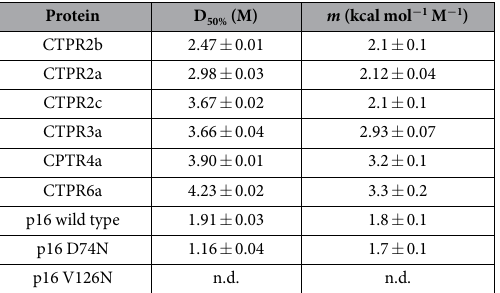
protein engineering/folding studies (Fig. S1(a)). Figure S1(b) shows the normalised data. The fluorimeter and plate-reader data overlay, and the CD data also give similar results within error (see D 50% and m -values listed in Table S1). The final set of samples that we tested using the plate-reader method were a selection of previously published proteins kindly given to us by colleagues in Cambridge. They are representative of proteins having a range of different stabilities, folding behaviour (two/three-state) and also extinction coefficients (Figs S2 and S3). All gave high-quality data, and the free energies of unfolding obtained were in agreement with the previously published values 12–14 .